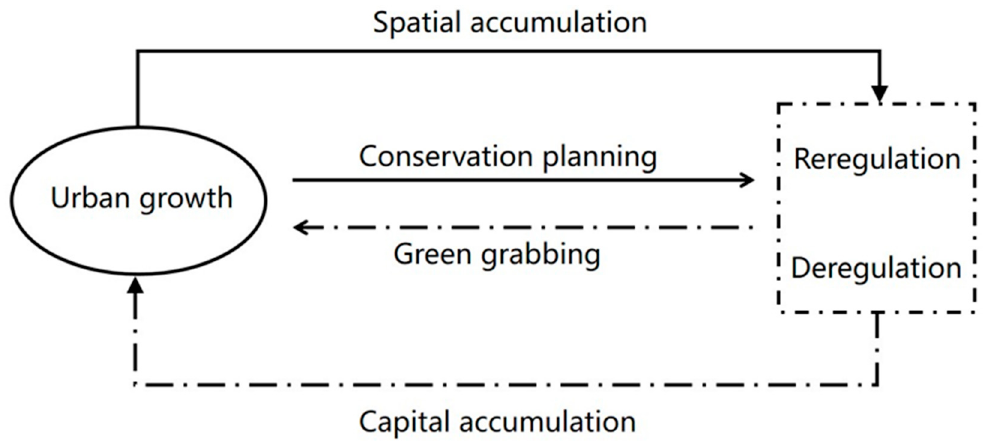
Figure 1. The Analytical Framework.